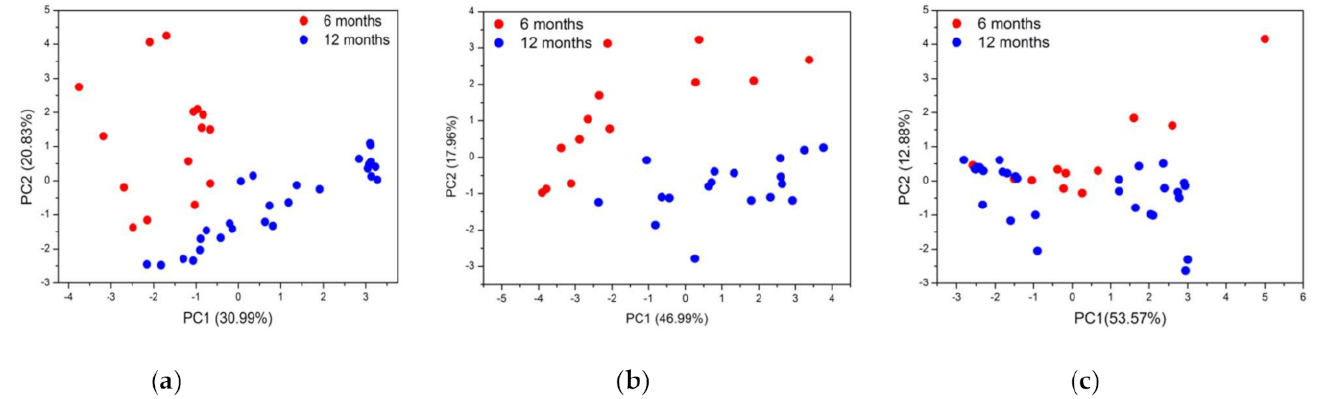
Figure 14. Score plot (PC1 vs. PC2) after both time intervals exposure to ( a ) sea, ( b ) flood tides, ( c )